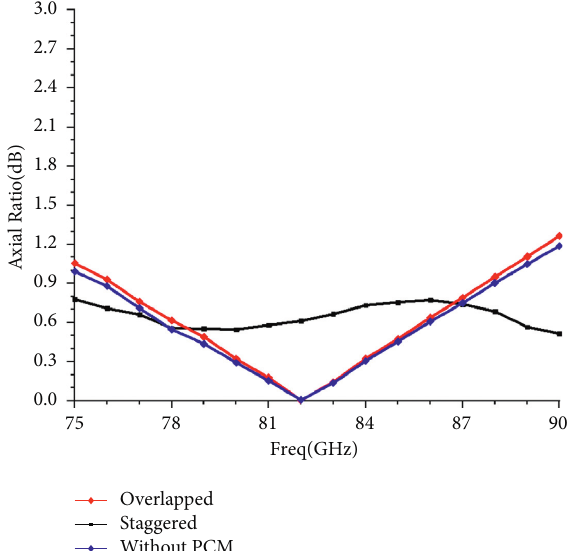
Figure 12: The axial ratio of different arrangements of slots and